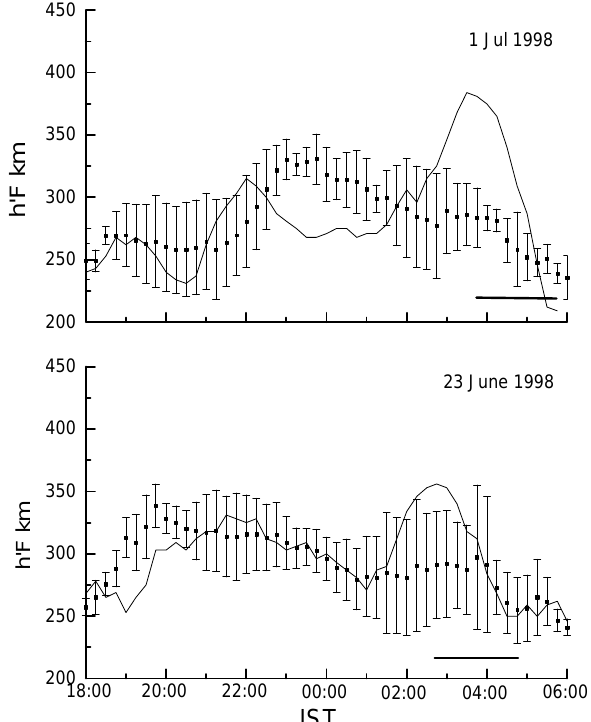
Fig. 2. Nocturnal variation of the F-layer virtual height (h 0 F) on two typical post midnight spread-F days during the summer solstice months. The points show the mean F-layer height of magnetically quiet non spread-F days and the vertical line shows the standard deviation. The horizontal solid line indicates the presence of spread- F on ionograms.